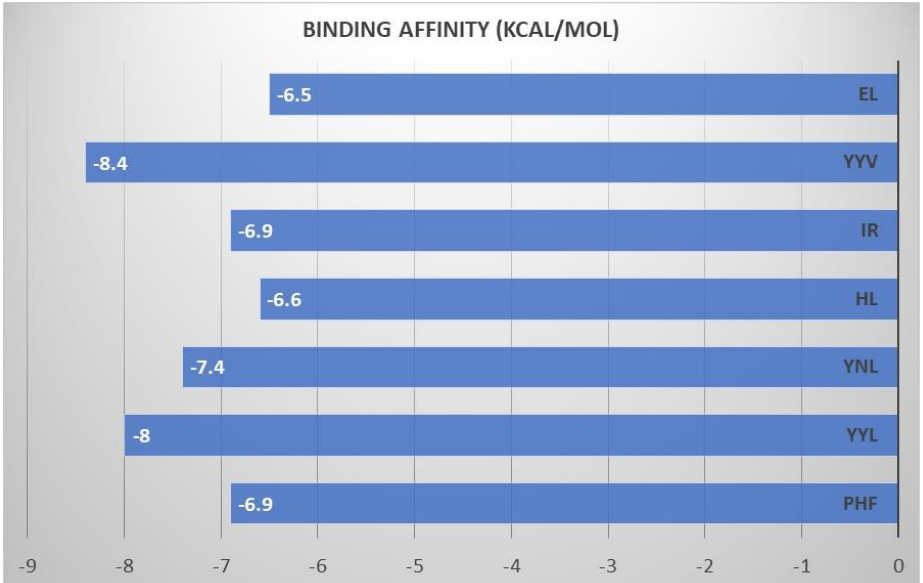
Figure 2. Binding free energy (binding activity) of ligand (peptides).